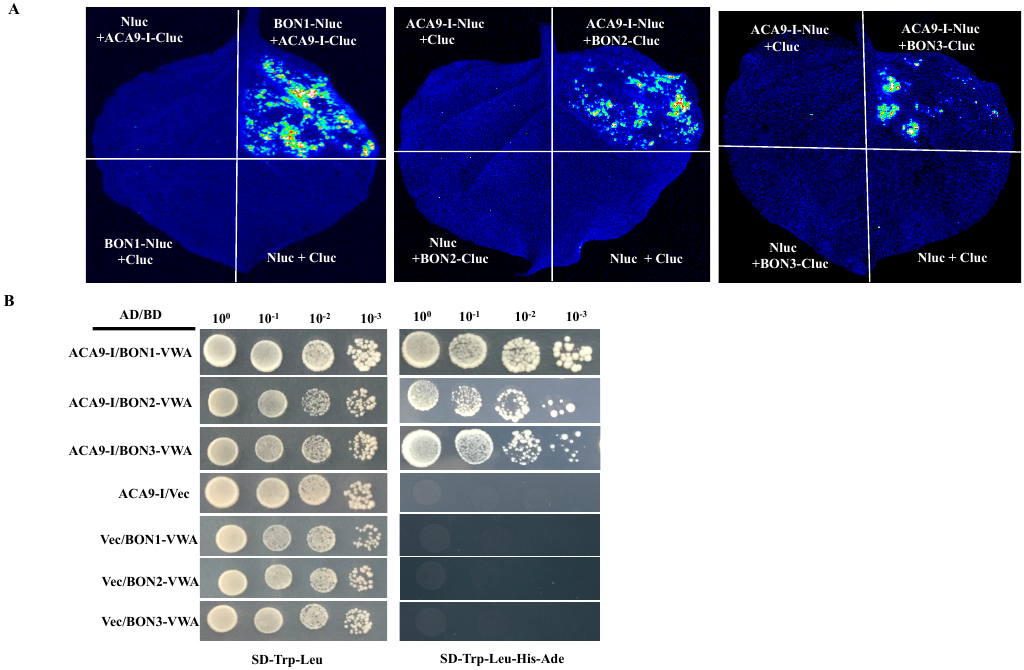
Figure 1. Protein-protein interaction between ACA9 and BON1 ， BON2 ， BON3. A. Split-LUC assay of the interaction of BON1,BON2,BON3 with the first segment of ACA9. The indicated combinations were used as controls. B. Yeast-two-hybrid assay between the first segment of ACA9 and the VWA domain of BON1, BON2, BON3. The various controls for yeast two hybrid.